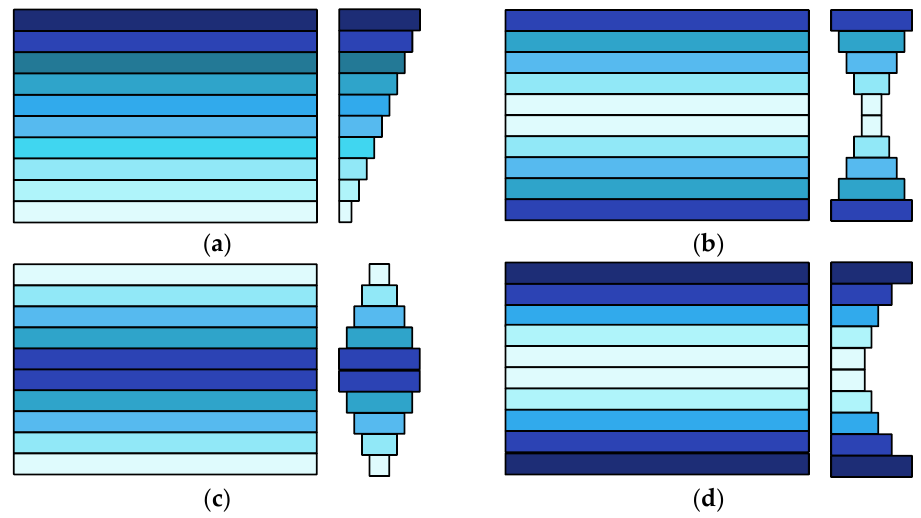
Figure 2. Volume fraction distribution of reinforcement particles: ( a ) V- type distribution; ( b ) X- type distribution; ( c ) O-type distribution;( d ) C-type distribution.